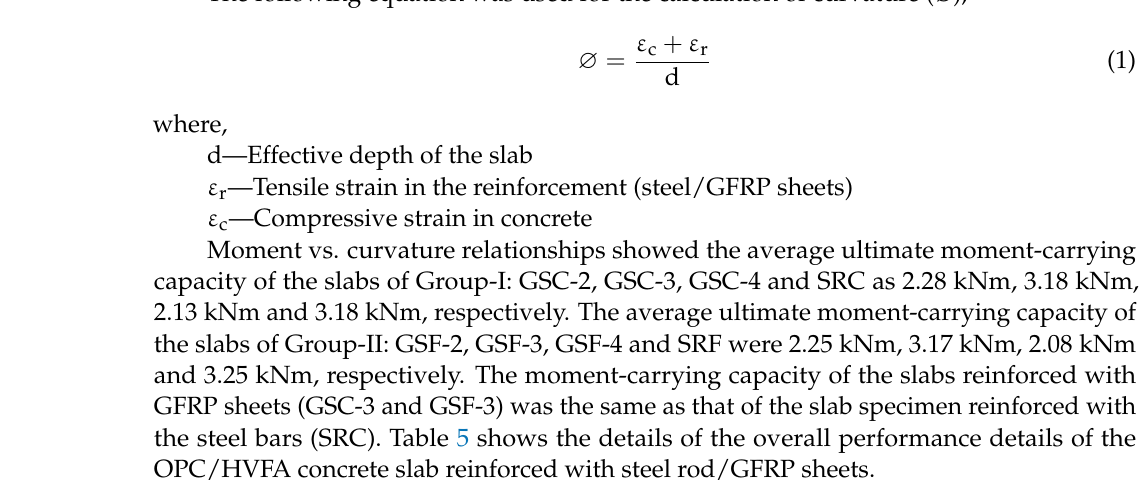
Table 5. Overall performance details of the concrete slab reinforced with steel rod/GFRP